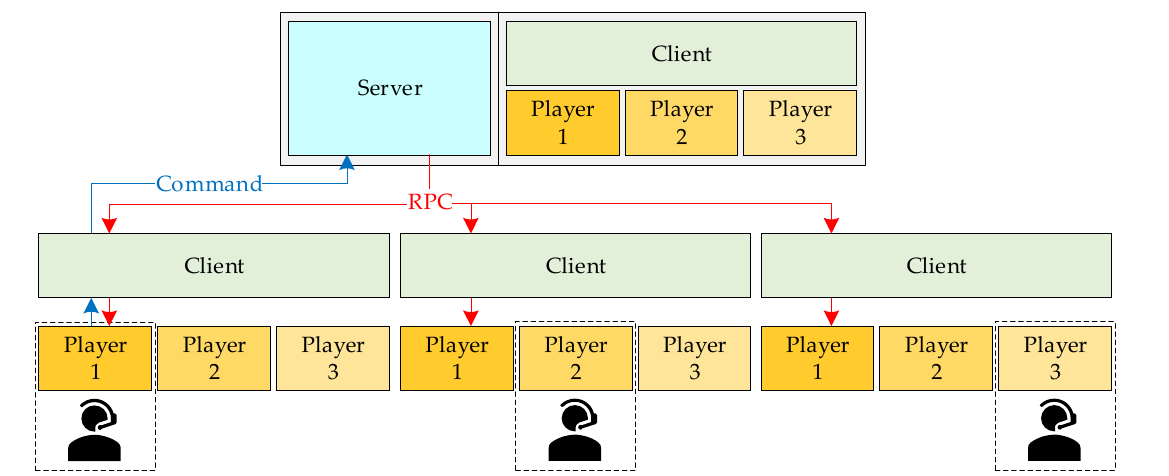
Figure 15. Basic diagram of the communication (remote procedure call, RPC) between the server and the clients (participants of the experience).